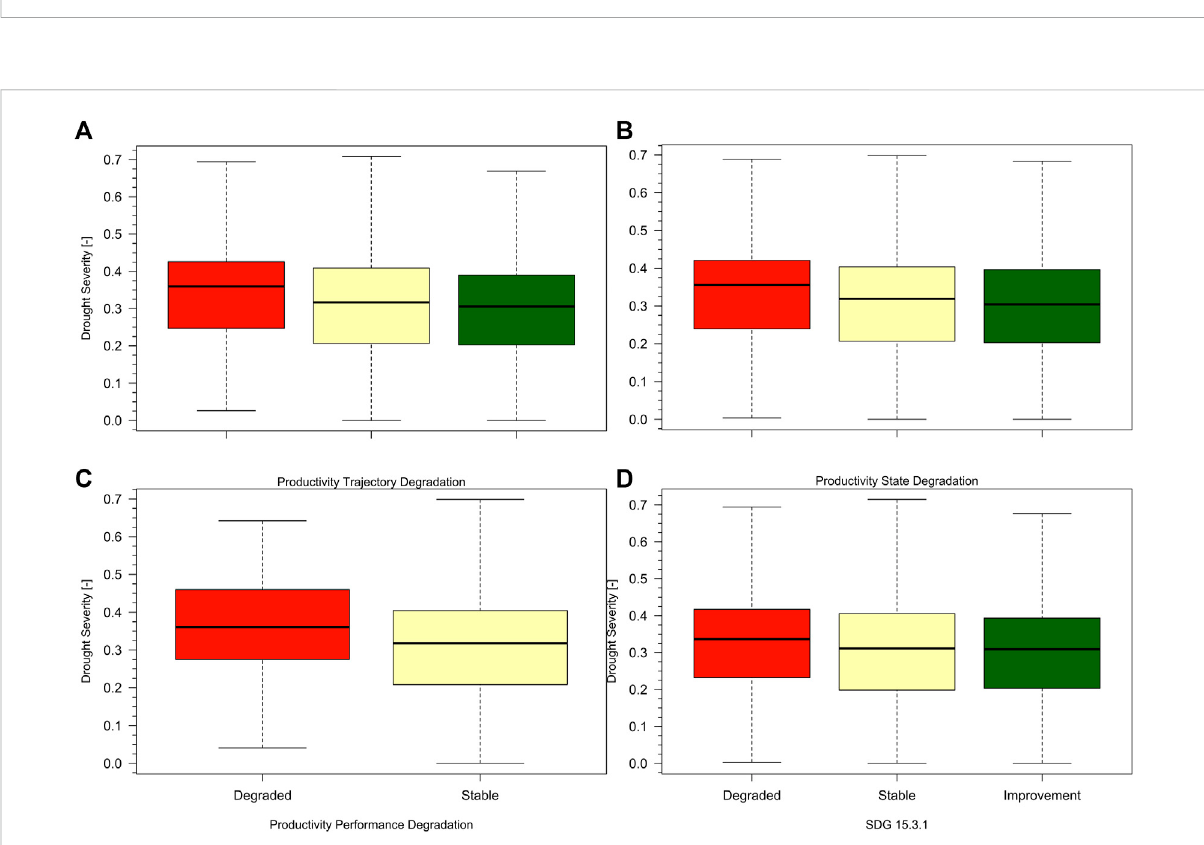
FIGURE 6 BoxplotsshowingthescPDSI-basedaveragedroughtseverityforthe (A) productivitytrajectorydegradation; (B) productivitystatedegradation; (C) productivity performance degradation; and (D) the SDG indicator 15.3.1 at benchmark sites randomly distributed in the Amazon basin for the period 2001 – 2020. For all panels, the differences in average drought severity between the degraded, stable, and improvement categories